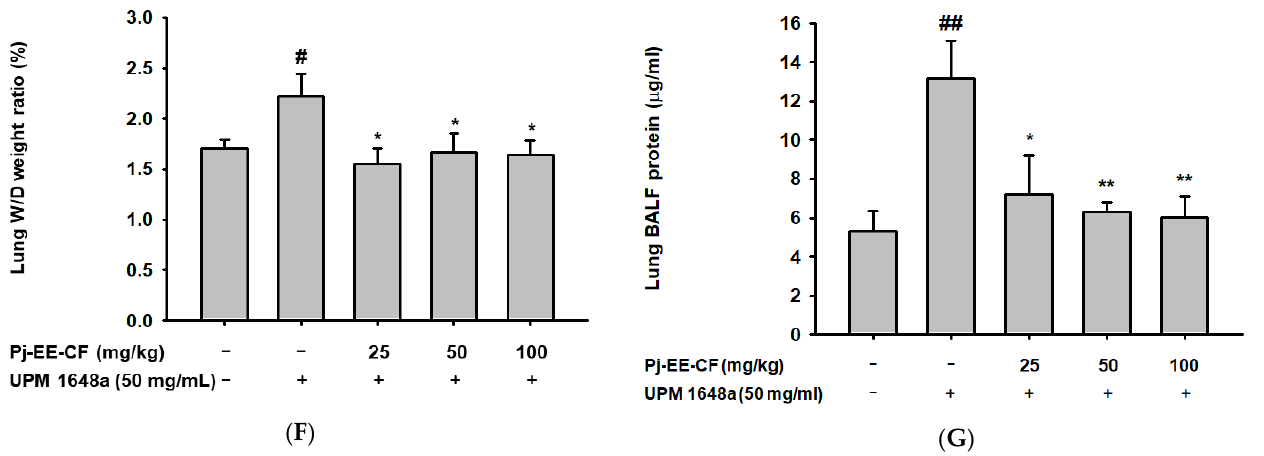
Figure 2. Pulmonary pathological alteration after UPM 1648a instillation and Pj-EE-CF administration in mice. ( A ) Representative image of the pathologic features of lung tissues prepared with five mice per group. Lung tissues from UPM 1648a and Pj-EE-CF treated mice were H&E stained. ( B ) Lung injury score of pulmonary tissue in each group. ( C ) A fluorescence microscopy image of macrophage and iNOS in lung tissue. Immunofluorescence was employed to assess macrophage infiltration (F4/80: red) and iNOS (green), and nuclei were stained with DAPI (blue). ( D , E ) Quantification of fluorescence intensity. Fluorescence intensities of F4/80 and iNOS were analyzed using Image J software and fluorescence intensities relative to control were calculated as percentage and expressed as mean ± SD.( F ) Lung wet/dry (W/D) ratio in each group. The pulmonary water content was investigated by analyzing the lung W/D ratio. ( G ) Protein concentration in BALF prepared from UPM 1648a-exposed mice orally pretreated with Pj-EE-CF (25 – 100 mg/kg) was determined by the Bradford assay. All assays depicted in ( A – G ) were performed with five mice per group. Results ( B , D – G ) are presented as mean ± SD. # p < 0.05 and ## p < 0.01 compared to normal (non-treatment), * p < 0.05 and ** p < 0.01 compared to control (UPM 1648a alone).